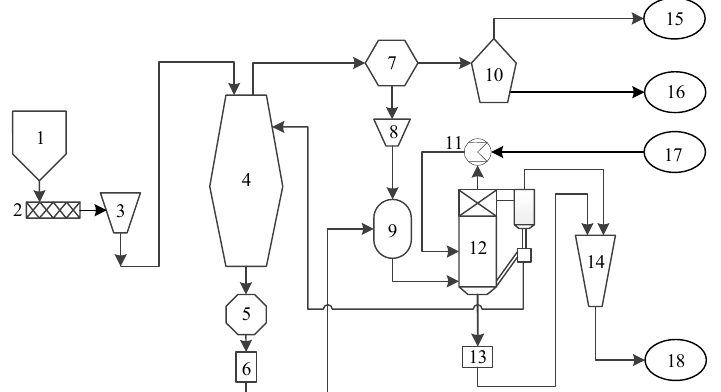
Figure 1. Schematic diagram of oil shale retorting by a solid heat carrier moving bed with inter- nals.